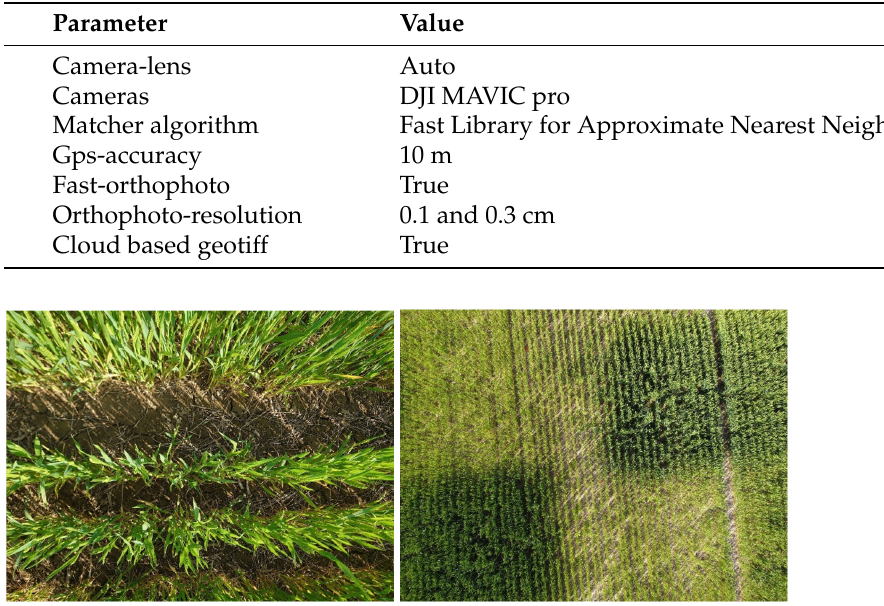
Figure 2. The collected images. The left one is collected near the ground. The right one is collected from the